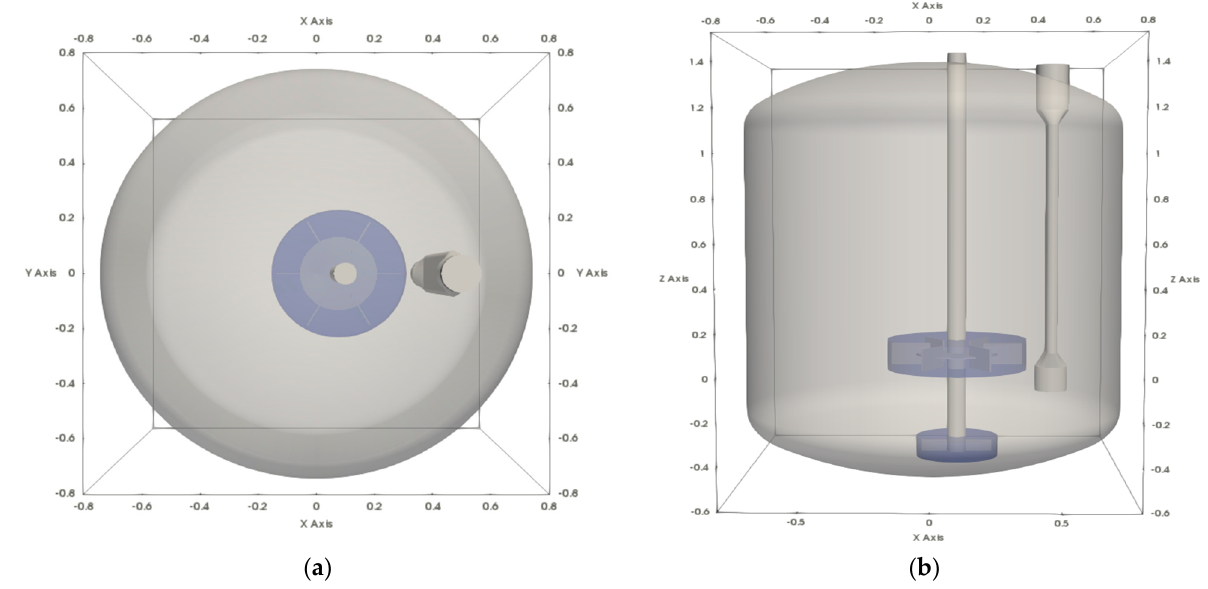
Figure 2. CAD model of the reactor showing the side view ( a ) and upper view ( b ).